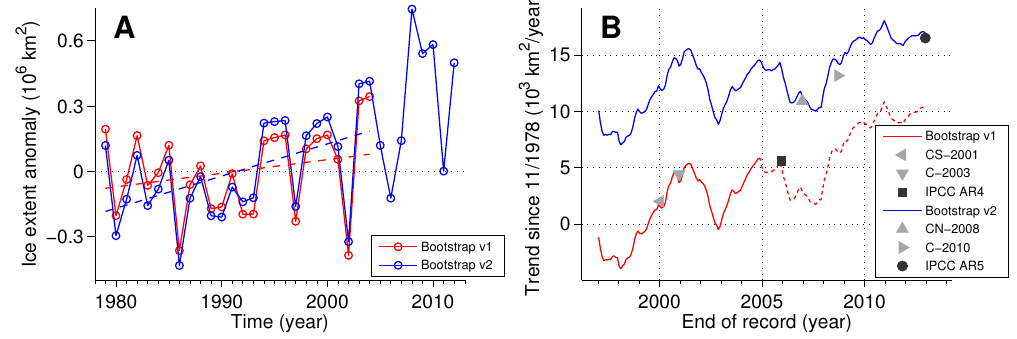
Figure 1. Antarctic sea ice extent calculated with the current Bootstrap data set (Version 2, blue), as well as an ostensibly nearly equivalent version of the data set that was distributed previously (Version 1, red). (A) Annual-mean ice extent anomalies from the 1979–2004 mean. Trends for the two annual time series, calculated for the period 1979–2004, are indicated by dashed lines. (B) Trends in the monthly-mean ice extent records truncated at a range of endpoints (curves) and compared with values published previously (symbols). Trends reported in the literature, which are plotted above the end date of the data set considered in each study, are from four studies (Comiso and Steffen, 2001; Comiso, 2003; Comiso and Nishio, 2008; Comiso, 2010), the IPCC AR4 (IPCC, 2007), and the IPCC AR5 (IPCC, 2013) (see Appendix A). The red dashed line is an approximate continuation of the Version 1 data set using Version 1B (see Sect. 3). Values published in the early to mid-2000s align with the Bootstrap Version 1 curve, and values published more recently align with the Bootstrap Version 2